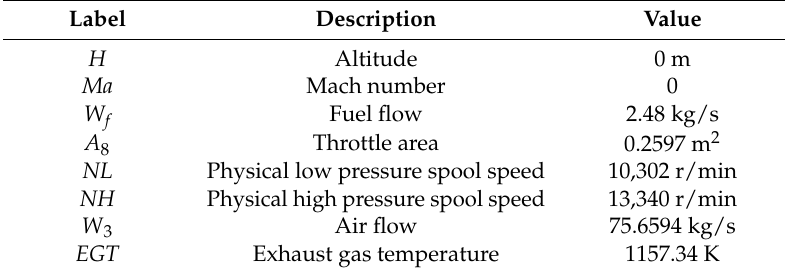
Table 1. Design point specifications of the examined engine.